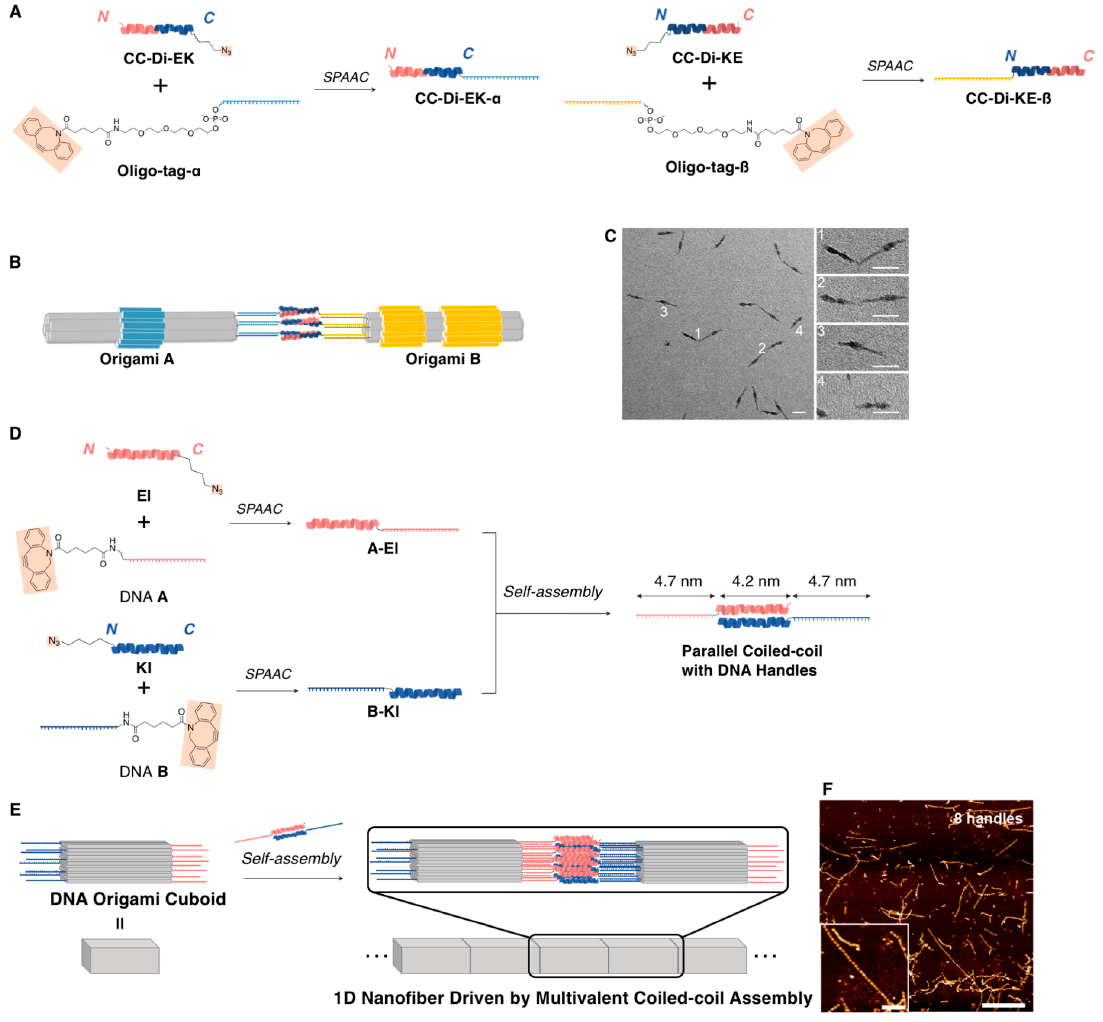
Figure 7. ( A ) Sequences of the coiled-coil heterodimers that formed the peptides ( CC-Di-EK and CC-Di-KE ) that were conjugated to the oligonucleotides ( α , β ). ( B ) Schematic illustration and ( C ) a representative TEM image of the connection of two distinct one-dimensional DNA origami nanostructures ( Origami s A and B ) by the specific formation of peptide coiled-coil heterodimers. ( D ) Sequences of the coiled-coil heterodimers that formed the peptides ( EI and KI ) that were conjugated to the oligonucleotides (DNA A and B ). ( E ) Schematic illustration and ( F ) representative AFM images to obtain long one-dimensional arrays of DNA origami cuboid nanostructures. Scale bar: 50 nm for C and 1 μ m (250 nm (inset)) for F . Adapted from [69,70]. Copyright 2019 and 2020 American Chemical Society.